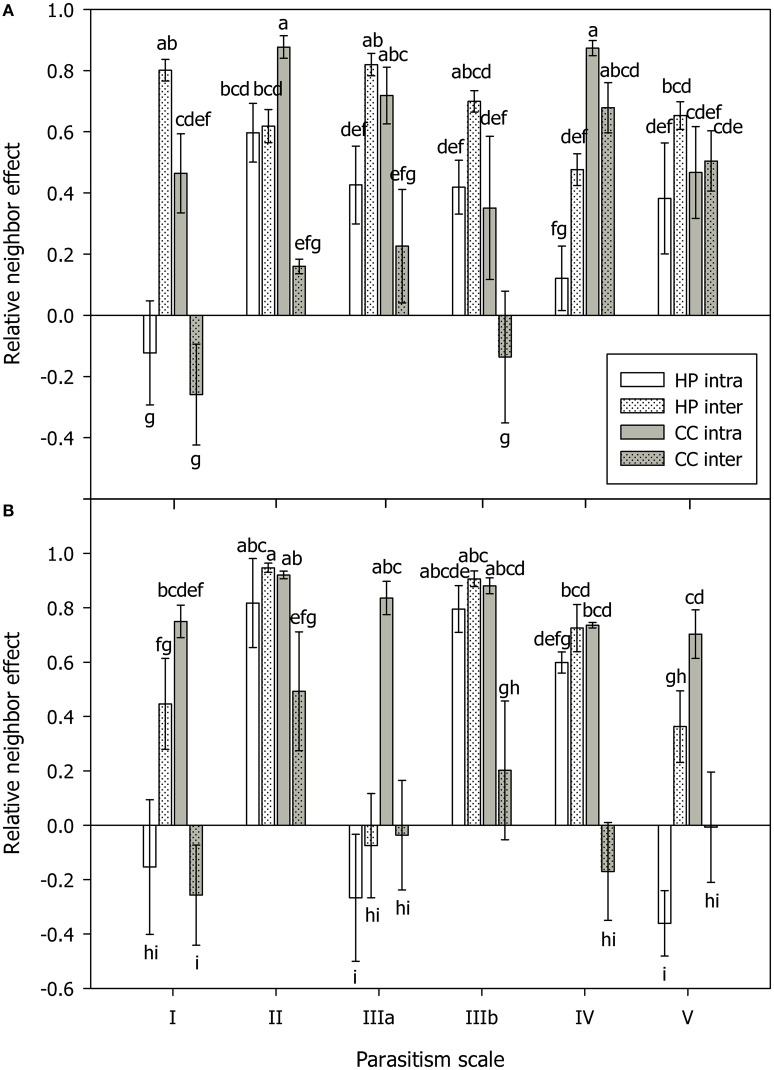
Relative neighbor effect (RNE) in mycorrhizal (A) and non-mycorrhizal (B) plants of Hieracium pilosella (HP, white) and Corynephorus canescens (CC, gray) in intraspecific (intra, open bars) and interspecific (inter, dotted bars) competition under conditions along a theoretical scale of mycorrhizal parasitism potential (parasitism scale) with I standing for hypothesized strong mutualism to V standing for hypothesized parasitism. Although, the parasitism scale can only be applied to mycorrhizal plants, the results for non-mycorrhizal plants were arranged in the same way for reasons of clarity. For calculation of RNE please see Materials and Methods Section. Different letters indicate significant differences at P = 0.05 (ANOVA). Means ± s.e., n = 5.